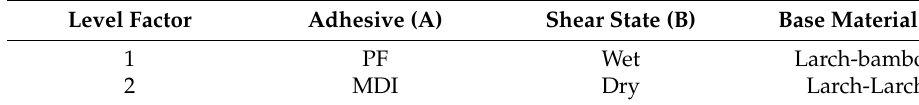
Table 2. Test combination of specimens.